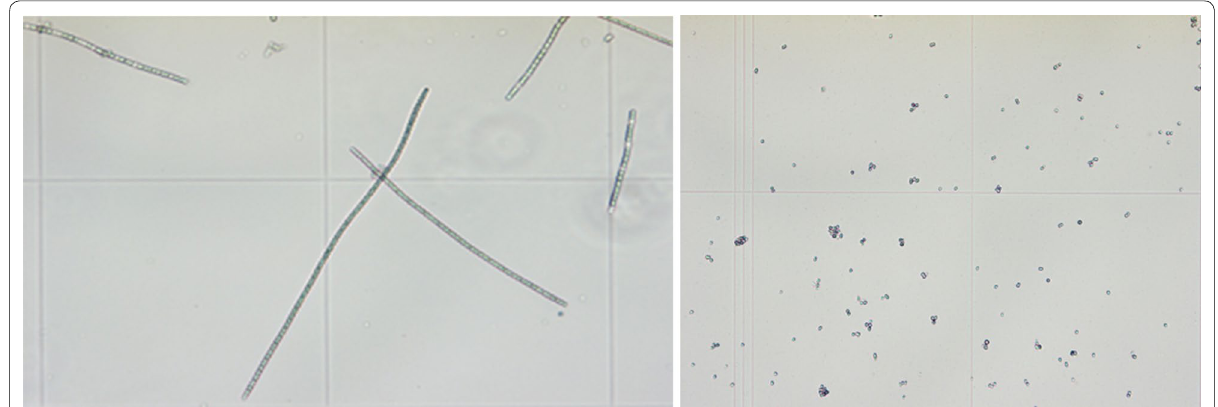
Fig. 3 Marine cyanobacteria Anabaena spec. (left) and Synechocystis spec. (right) used in the marine cyanobacteria test